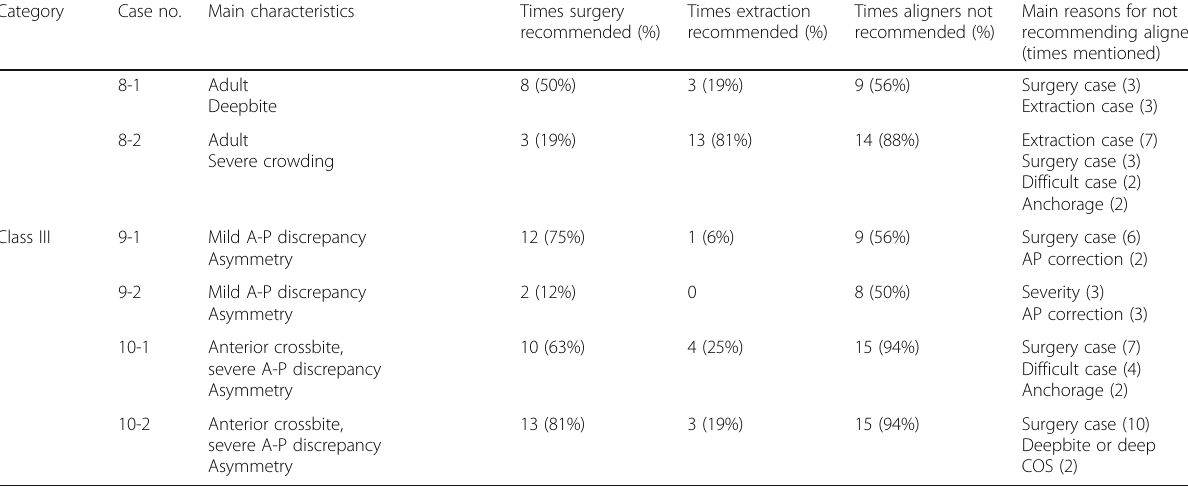
Table 5 Characteristics, treatment plans, and Invisalign® recommendations (Continued) Category Case no.